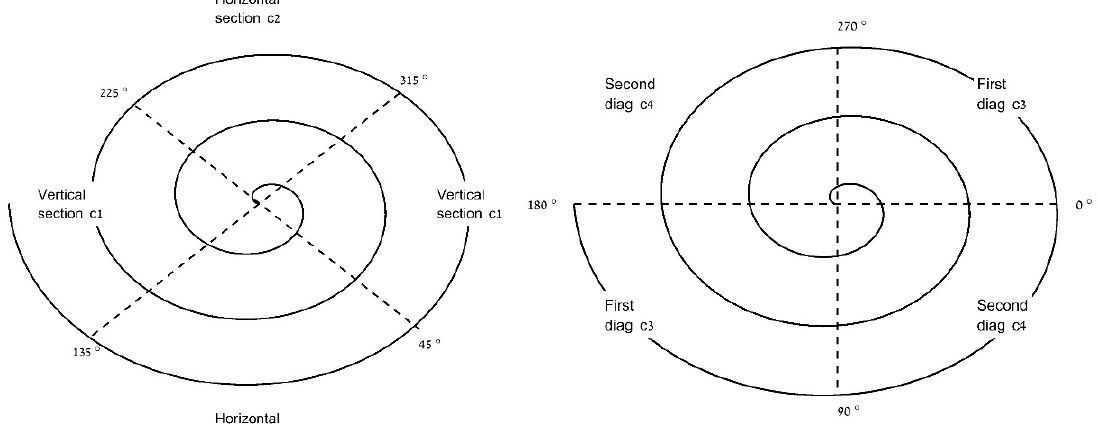
Figure 3. An illustrative example of the spiral sections. The angle is defined in the clockwise drawing direction: ( left ) vertical and horizontal sections c1 and c2; ( right ) diagonal sections c3 and c4. (c1) Vertical section: 315–45° and 135–225°. (c2) Horizontal section: 45–135° and 225–315°. (c3) First diagonal: 270–360° and 90–180°. (c4) Second diagonal: 180–270° and 0–90°.